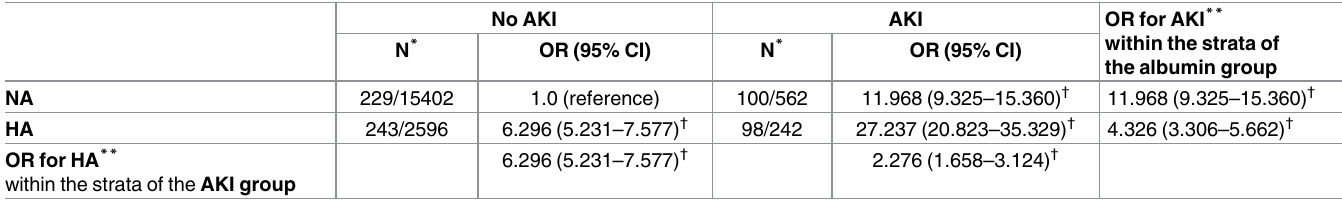
Table 4. Interaction analysis between hypoalbuminemia and acute kidney injury for